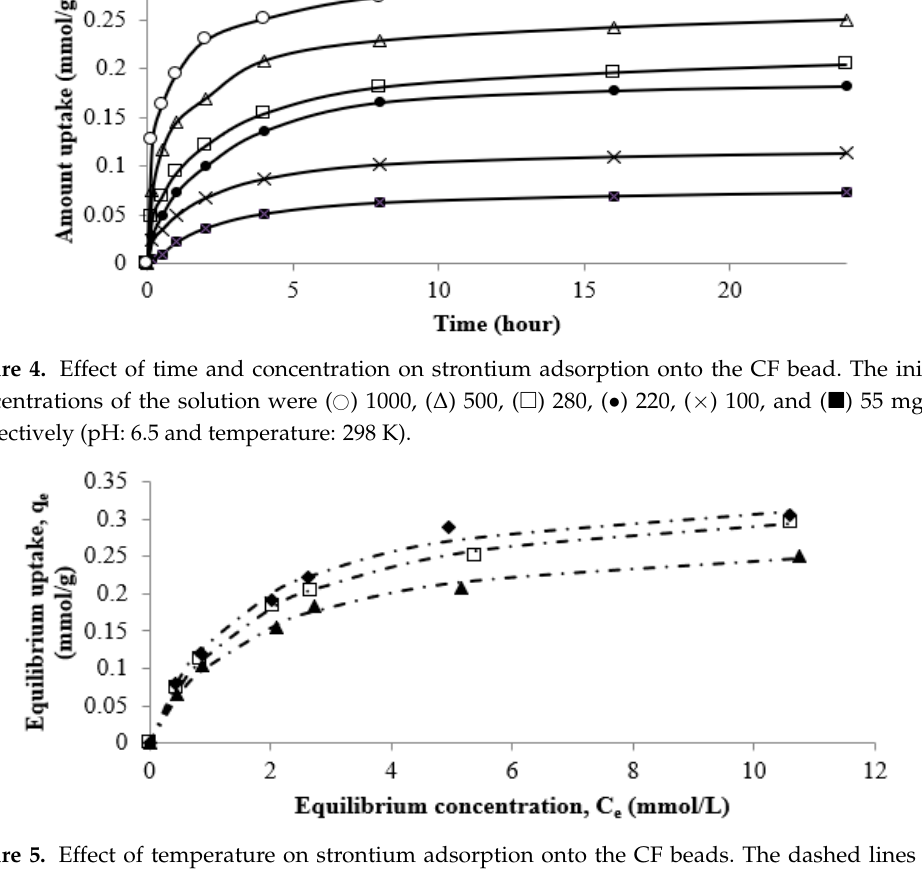
Figure 5. Effect of temperature on strontium adsorption onto the CF beads. The dashed lines are calculated from the one-site Langmuir equation, and the symbols ( ♦ ) 293 K, ( □ ) 298 K, and ( ▲ ) 308 K represent experimental data.